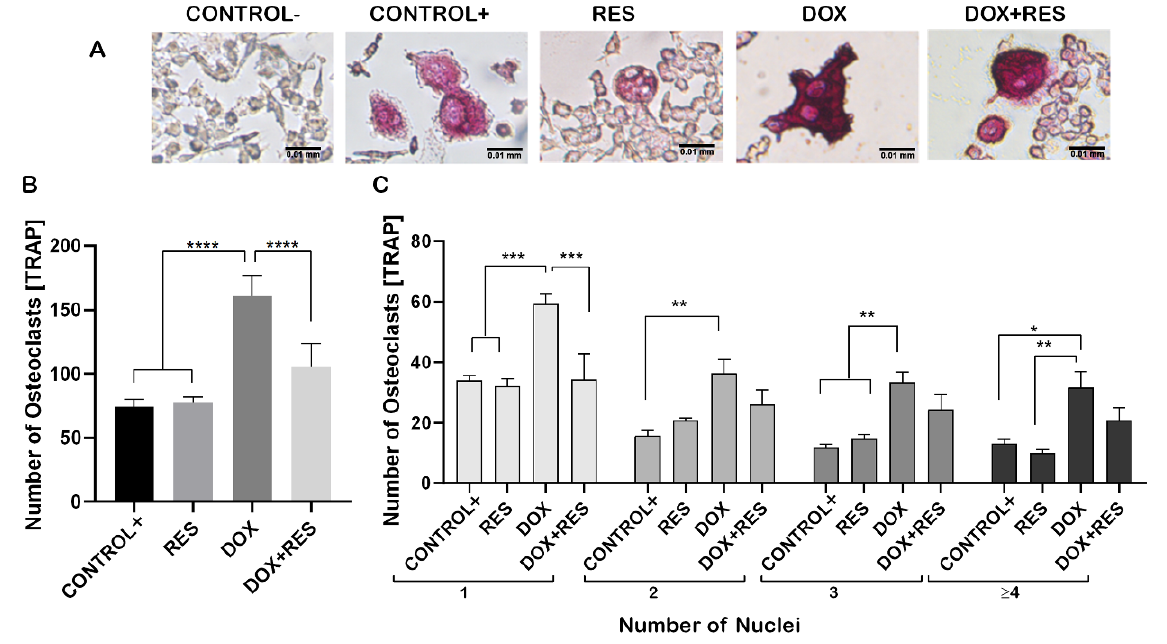
Figure 2. Resveratrol prevents doxorubicin-induced osteoclast differentiation. RAW 264.7 cells were cultured for 4 days with M-CSF (30 ng/mL) and RANKL (50 ng/mL) and treated with resveratrol (RES) and doxorubicin (DOX) alone or combined. TRAP-positive osteoclastic cells ( A ). Number of TRAP-positive cells ( B ). Number nuclei in TRAP-positive cells from the different treatments. Cells were grouped according to the number of nuclei: 1, 2, 3 or more than 4 ( ≥4 ) ( C ). One-way ANOVA, Tukey’s multiple comparisons test, *— p ≤ 0.05, **— p ≤ 0.01, ***— p ≤ 0.001, ****— p ≤ 0 .0001.